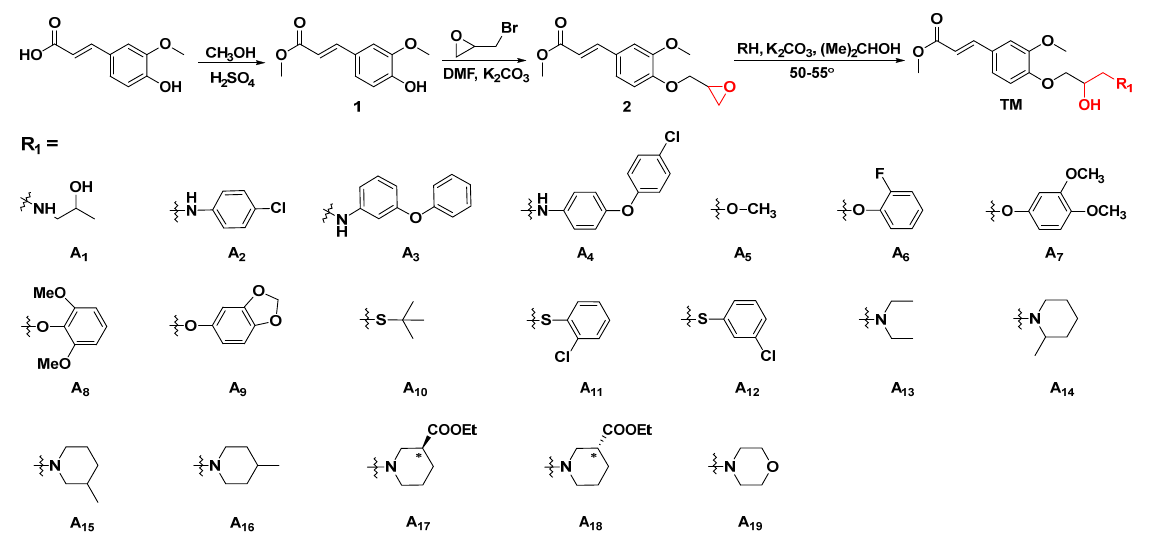
Figure 2. The synthetic route for the target molecules A 1 ‐ A 19 . Table 1. The in vivo anti ‐ TMV activity of synthesized compounds ( A 1 ‐ A 19 ) Conc. Inhibition Rate (%) Compound ( μ g/mL) Curative Effect Protective Effect